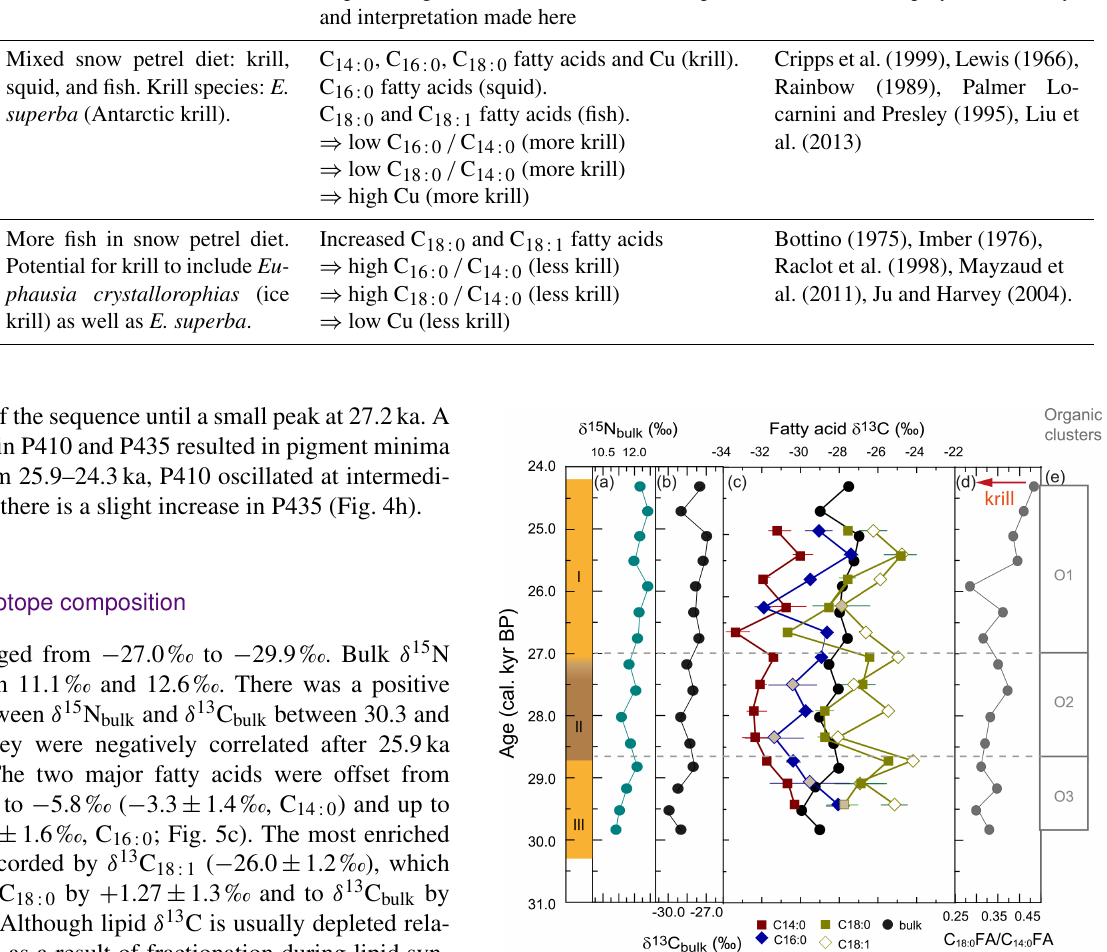
Table 3. Examples of snow petrel prey biochemistry and oceanographic conditions related to snow petrel diet and prey distributions. Snow petrels forage in close association with the sea ice, either at the sea-ice edge or in leads or polynyas within the sea-ice pack. The prey biochemistry information is used as a framework to interpret the chemical signatures recorded in stomach-oil deposit WMM7, including our use of fatty acid ratios to assess relative contributions of prey (Figs. 4 and 5). Environment Characteristics Expected signal recorded in stomach-oil deposit References for prey biochemistry and interpretation made here